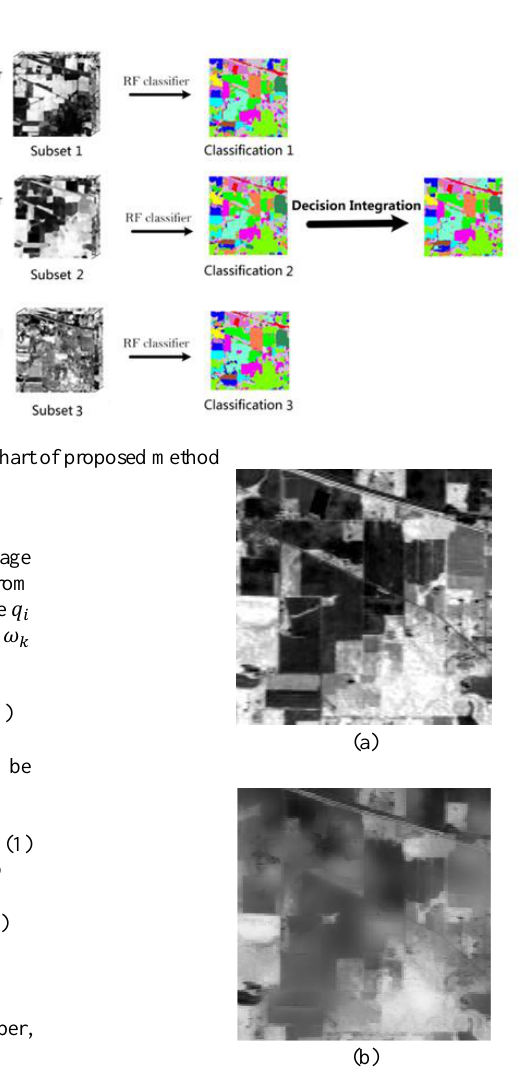
Fig. 2 (a) The first PC. (b)The filtered result of the first